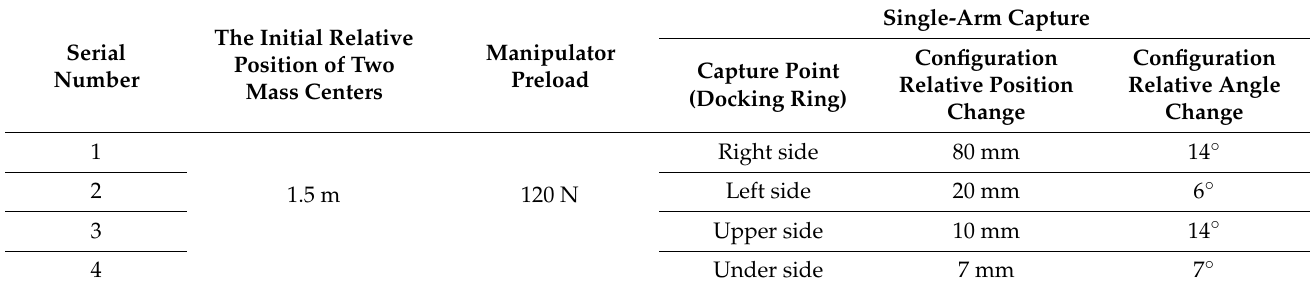
Figure 1. Post-capture control of space debris. Table 1. Configuration change in the combined spacecraft (single-arm capture).